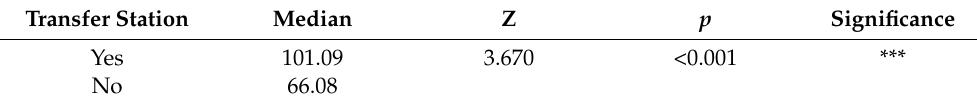
Table 2. Non-parametric test results for the “transfer